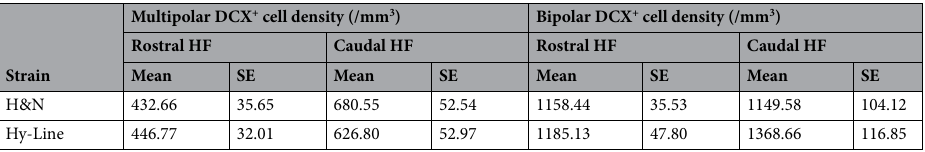
Table 5. Mean (M) and standard error (SE) for estimated densities of doublecortin (DCX) + cells with multipolar and bipolar morphologies in the rostral and caudal hippocampal formation (HF) of 14-week-old H&N and Hy-Line strain laying hen pullets. n = 12 for each